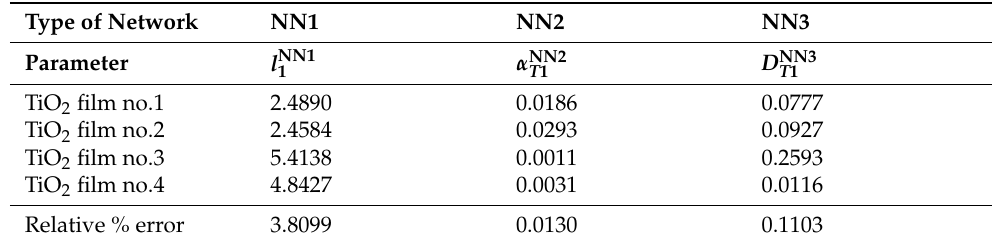
Table 4. Relative (%) error prediction of TiO 2 thin-film parameters NN1-3 on 4 signals from three bases “out of step” of training network.